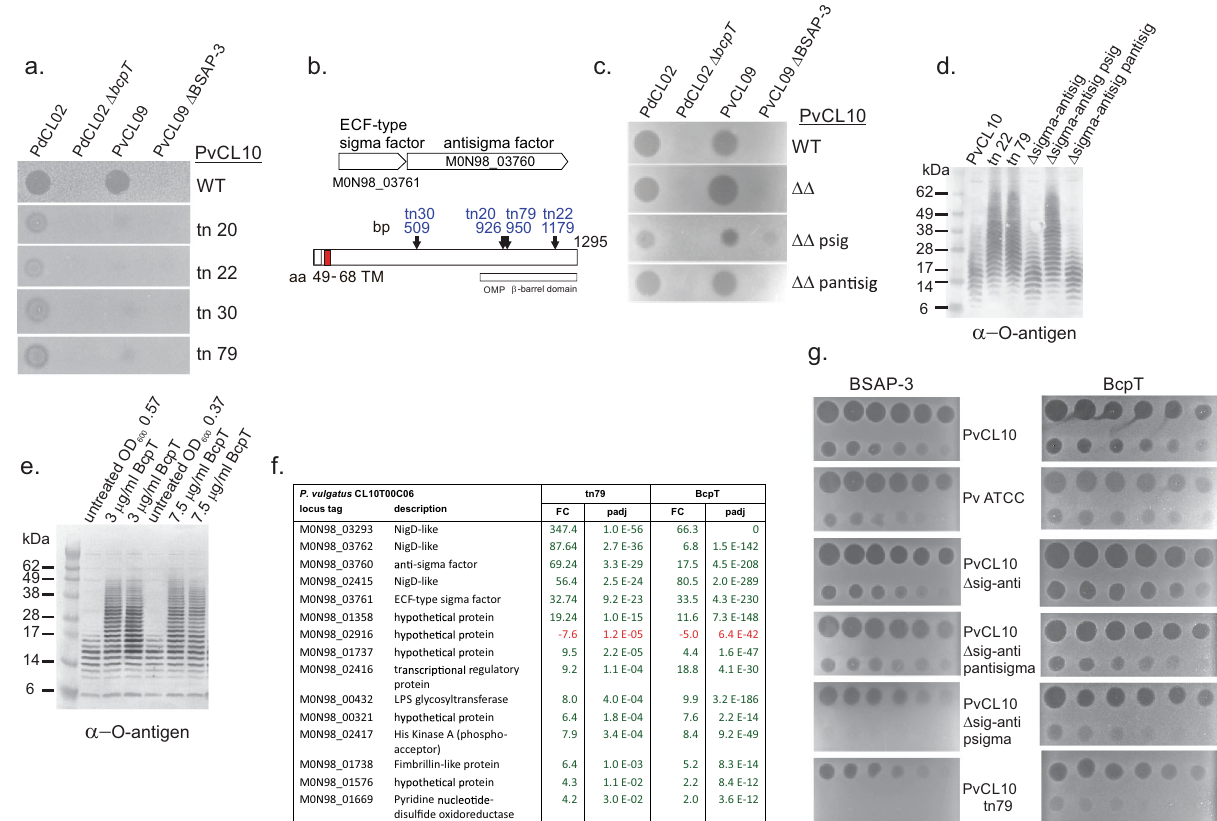
Fig. 6 A BcpT-induced protective regulon. a Agar spot overlay assays of four transposon (tn) mutants of PvCL10 that were slightly protected from BcpT and substantial protected from BSAP-3. b Orf map of the anti-sigma factor encoding gene (M098_03760) into which all transposons inserted showing the genetic context of the upstream gene encoding the cognate sigma factor (M0N98_03761). Bottom panel shows the regions of the anti-sigma factor including the inner transmembrane region shown in red and the outer membrane β -barrel region and sites of each of the four transposon mutants. c Agar spot overlay assays showing the sensitivity of the mutant strains of PvCL10 (indicated on right) to each of the toxin-producing strains or the toxin deletion mutants. d Western immunoblot showing LPS O-antigen sizes of various PvCL10 WT and mutant strains (psig and pantisig are plasmids containing the respective gene). The blot was probed with antiserum to PvCL10 O-antigen. e Western immunoblot of whole cell lysates of PvCL10 treated with two concentrations of BcpT for 3 h in duplicate or OD 600 matched untreated controls. Bacterial equivalent to 4 µ l of the culture were added to each well. The blot is probed with antiserum to the PvCL10 O-antigen. f List of the 15 genes that are differentially expressed using the strict cut-off criteria listed in the methods section in PvCL10 tn79 compared to WT PvCL10. Green indicates upregulation and red indicates downregulation. FC represents the fold-change and padj represents the p -value adjusted for multiple comparisons by DESeq2. All 15 genes are also differentially expressed when PvCL10 is treated with BcpT. g Agar spot overlay assays showing the susceptibility of various strains to dilutions of BSAP-3 and BcpT. The fi rst spot of the BSAP-3 plates is 1 µ g and the fi rst spot of the BcpT plates is 3 µ g and each consecutive spot is a 2-fold dilution left to right on the top row and then left to right on the bottom row. Overlay assays and western immunoblots were performed at least twice with consistent results. Source data are provided as a Source Data